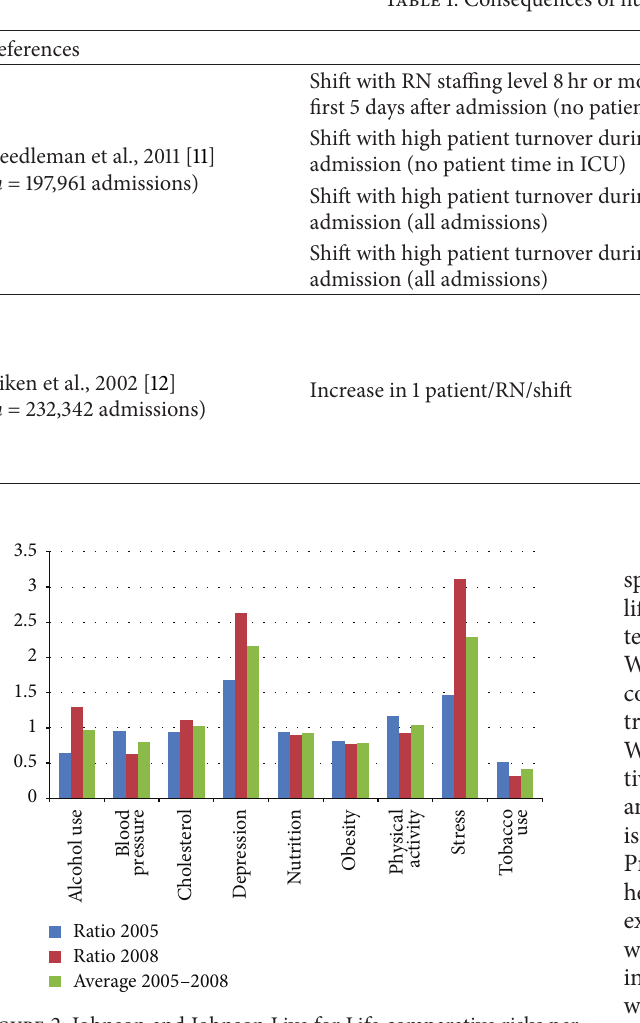
Figure 2: Johnson and Johnson Live for Life comparative risks per